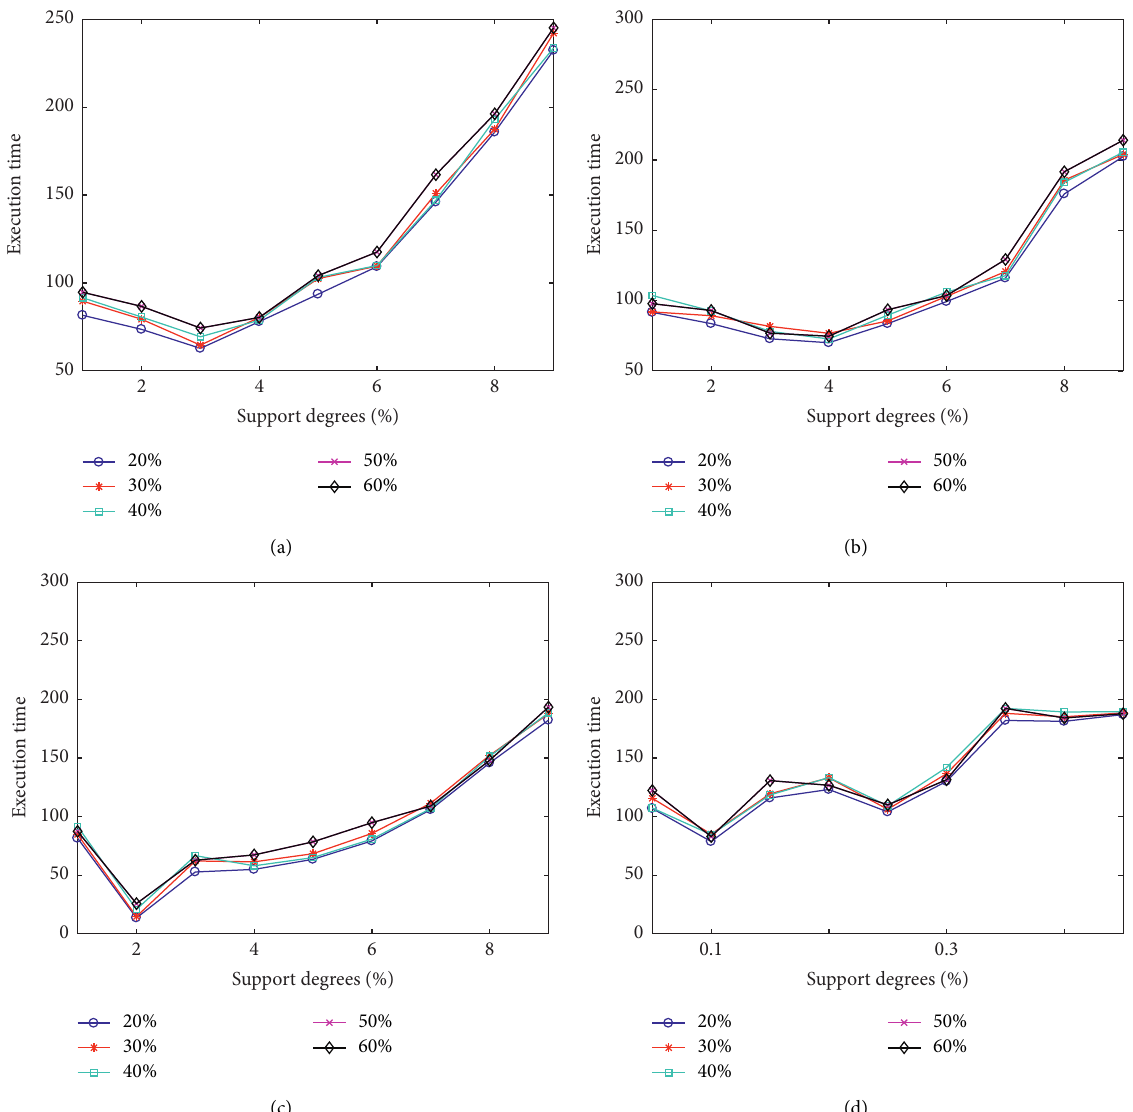
Figure 6: The execution time under different parameters. (a) 20% return rate. (b) 30% return rate. (c) 40% return rate. (d) 50% return